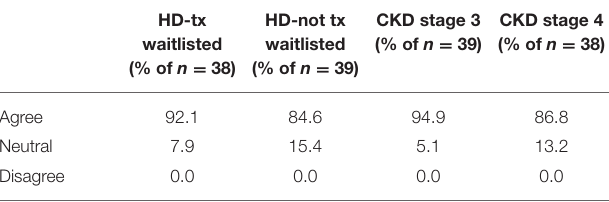
TABLE 7 | Medical director perspectives of whether HCV + dialysis or CKD patients should be treated with an anti-viral medication (China Medical Director HCV survey, 2021).